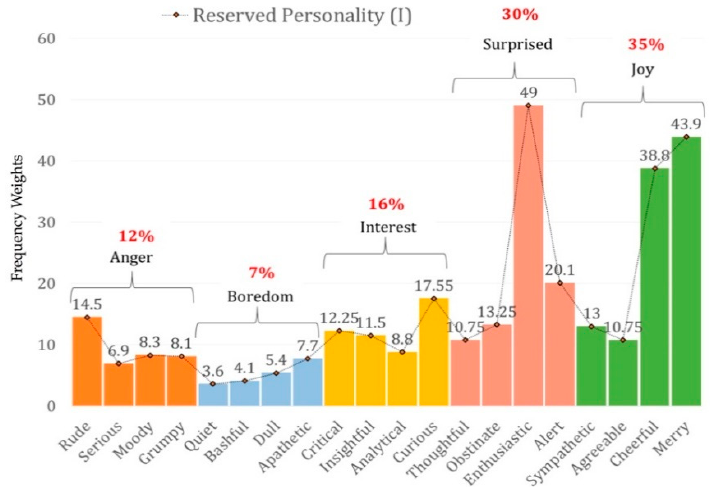
Figure 5. Reserved Personality (Factor I): behaviors at Level 3.